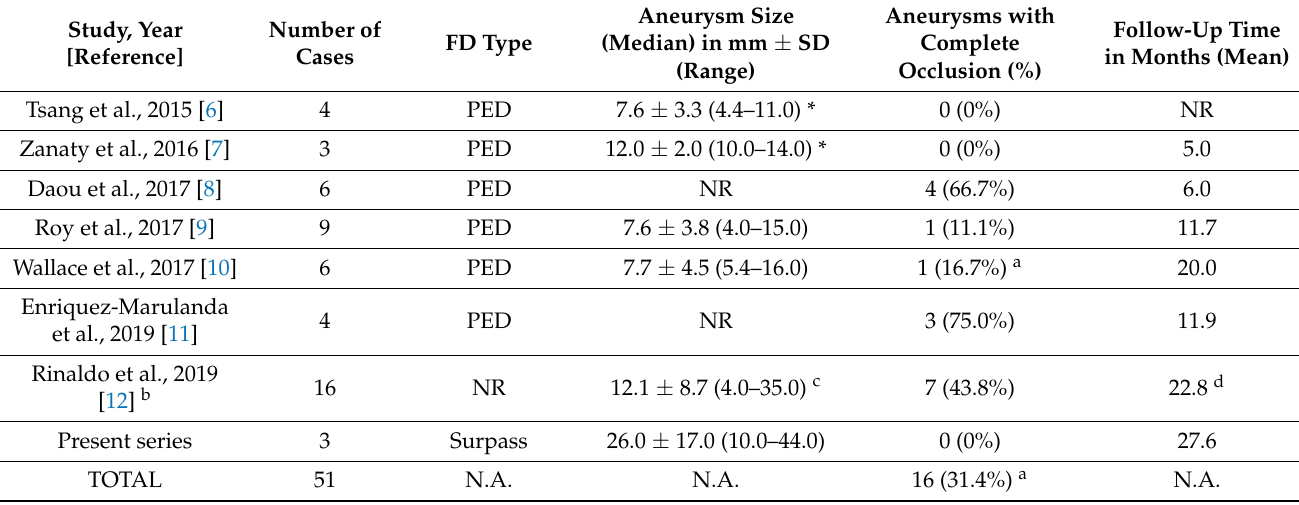
Table 2. Literature on flow diverter treatment for fetal type PCA associated PcomA